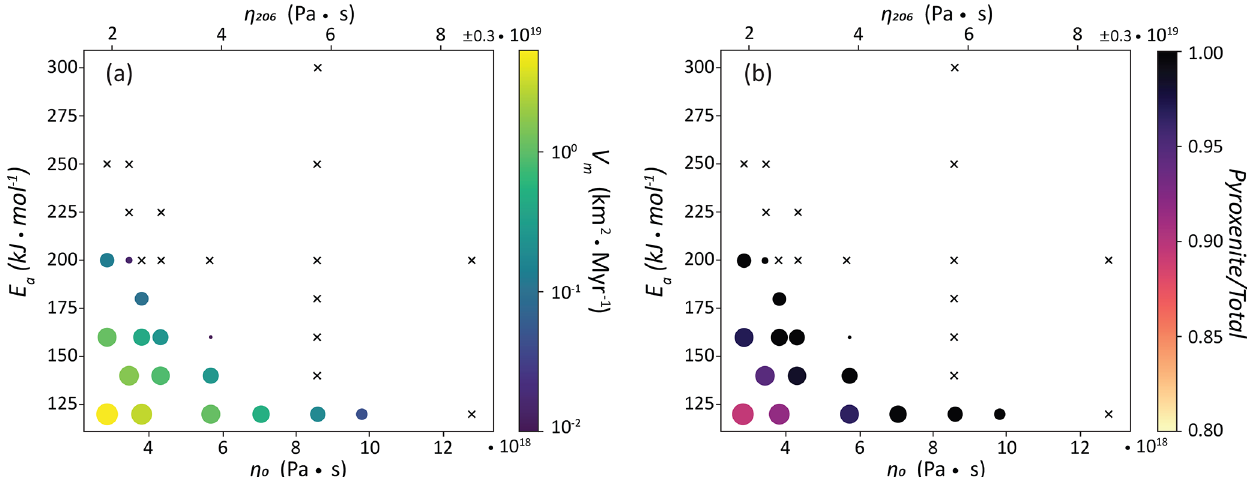
Figure 6. Scatterplots showing the melt property variation with respect to the reference viscosity ( η 0 ) and activation energy ( E a ). The upper axis η 206 refers to the viscosity in the asthenosphere measured at z = 206km depth on the oceanic side for all cases with E a = 200kJmol − 1 . For all other cases, this value slightly varies according to (very small) temperature changes related to the half-space cooling model (see Eq. 2) but by less than 5%. (a) Melt volume flux due to EDC (colored circles), measured at the point of maximum EDC-related vertical velocities (i.e., v z, rms ). Crosses mark cases in which no melting is detected. The size of the circles also scale with melt volume fluxes. Melt volume fluxes are reported in km 2 Myr − 1 due to the 2D character of the model (i.e., corresponding to km 3 Myr − 1 per km of plate in the out-of-plane direction). (b) Scatterplot showing the origin of the melting products (i.e., proportion of melt derived from pyroxenite vs. total melt; colored circles). Notation of crosses and size of circles as in (a) . Note that the color scale is set between 0.8 and